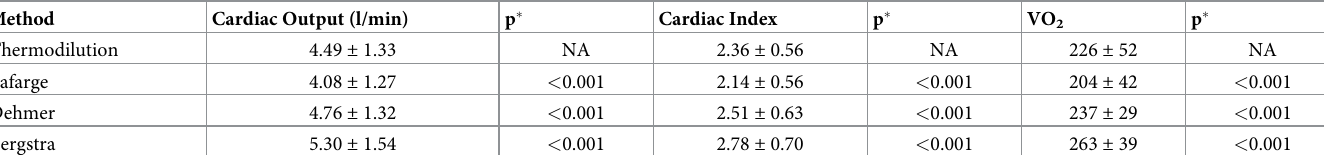
or � 20%. From the three established formulas, the De formula (43.9%) had the highest num- ber of patients with an error rate � 10% and the lowest number with an error rate � 20% (26.5%), as shown in Fig 2.